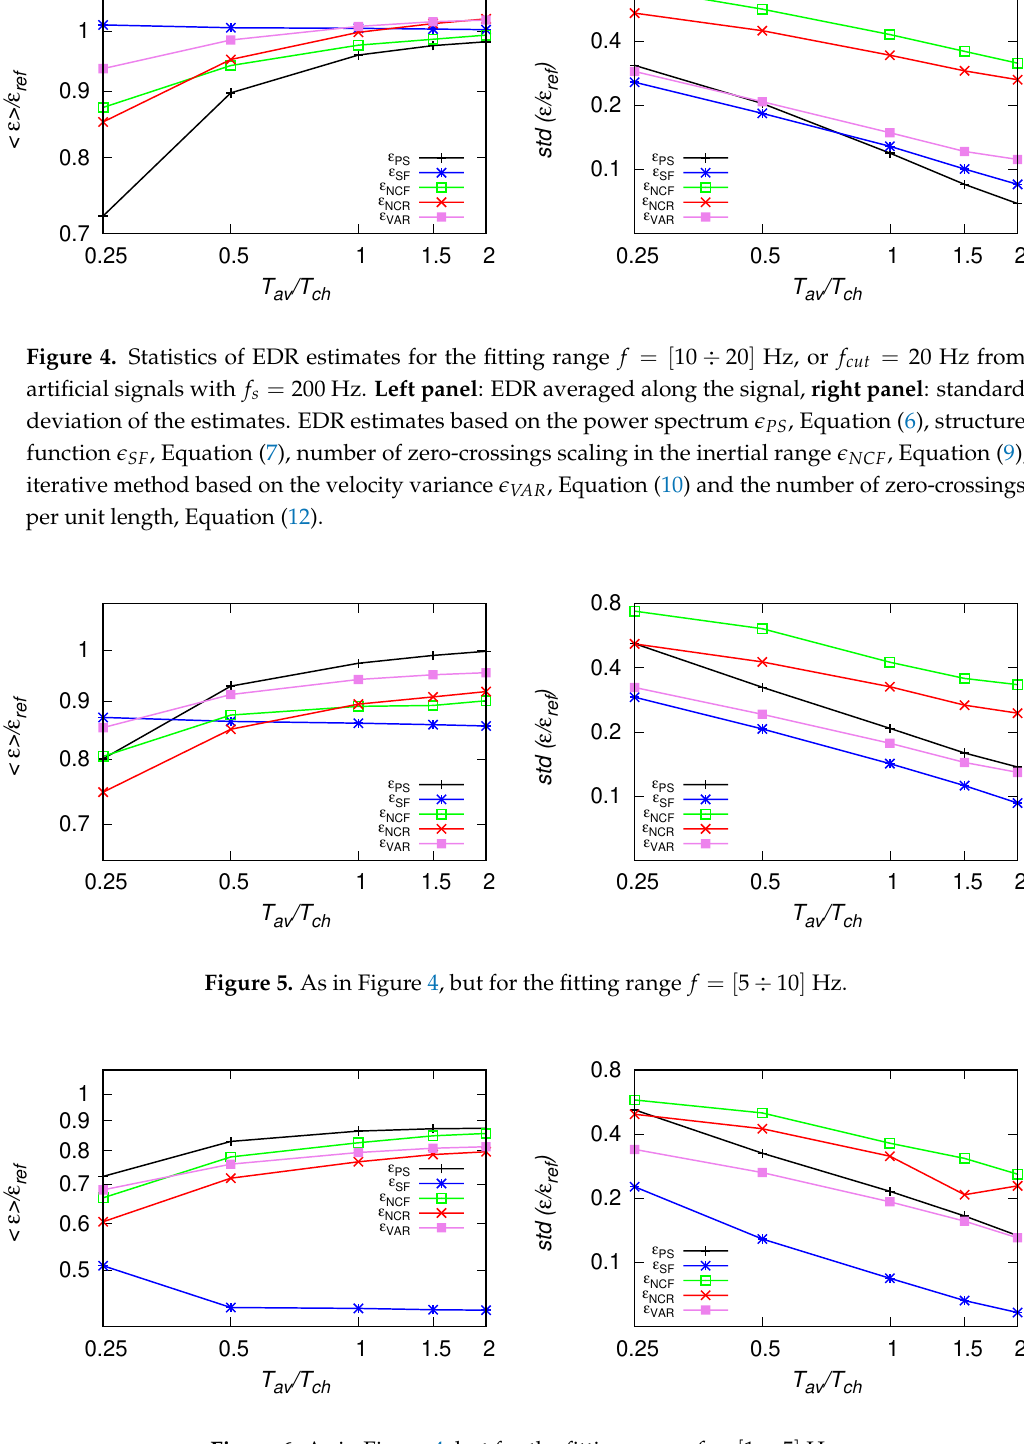
Figure 6. As in Figure 4, but for the fitting range f = [ 1 ÷ 5 ]